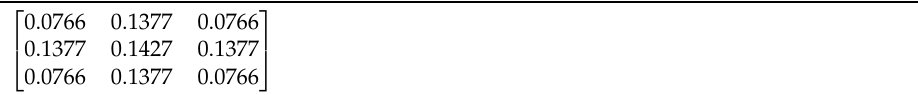
Table 3. Kernel used to smooth 20 m Sentinel-2